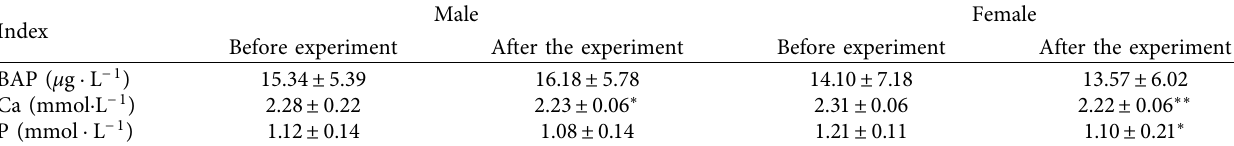
Table 2: Changes of blood biochemical indexes of bone metabolism in